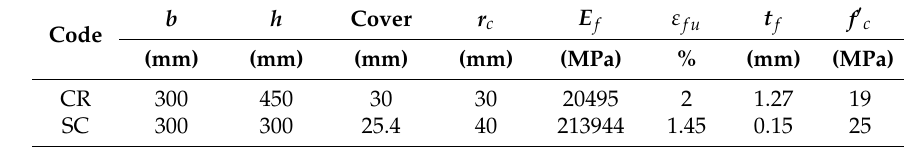
Table 1. Calibration specimens’ geometric, FRP and concrete properties. SC, square section case.